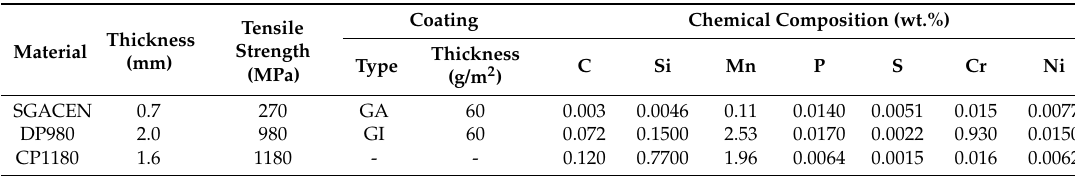
Table 1. Steel sheet material specifications.